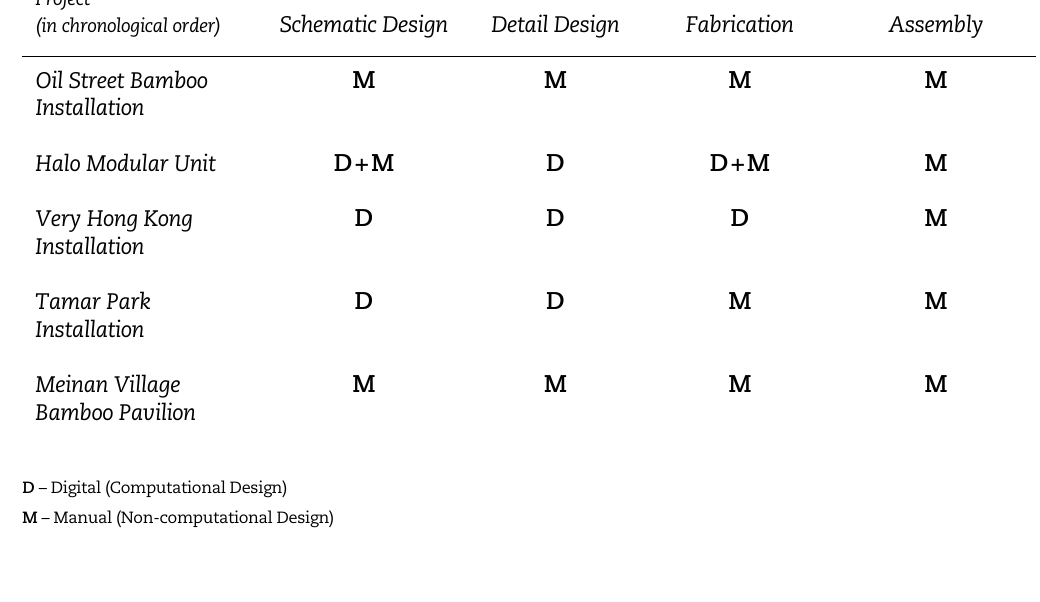
Table 1: Digital and manual design methodologies in exemplary design-fabricate-build projects